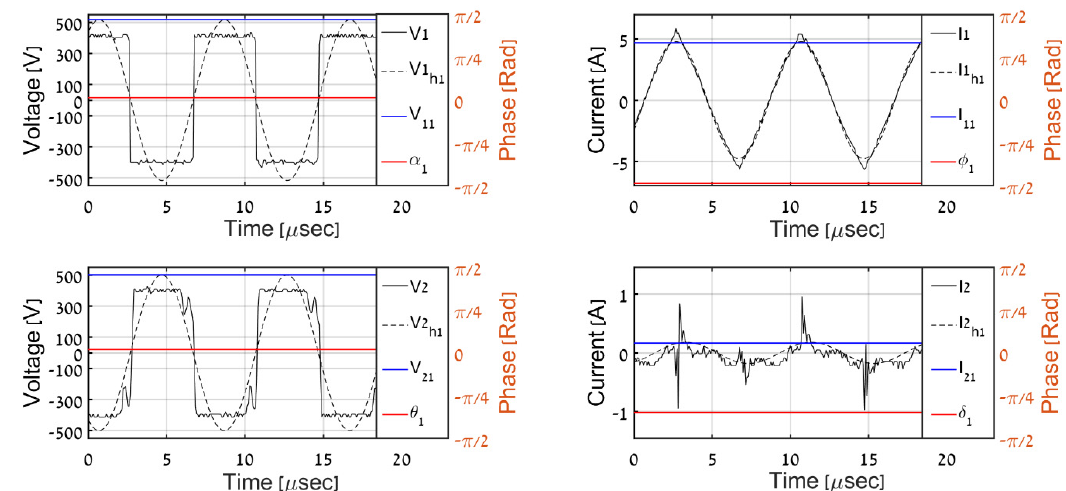
Figure 16. Experimental results, P O = 100 W.